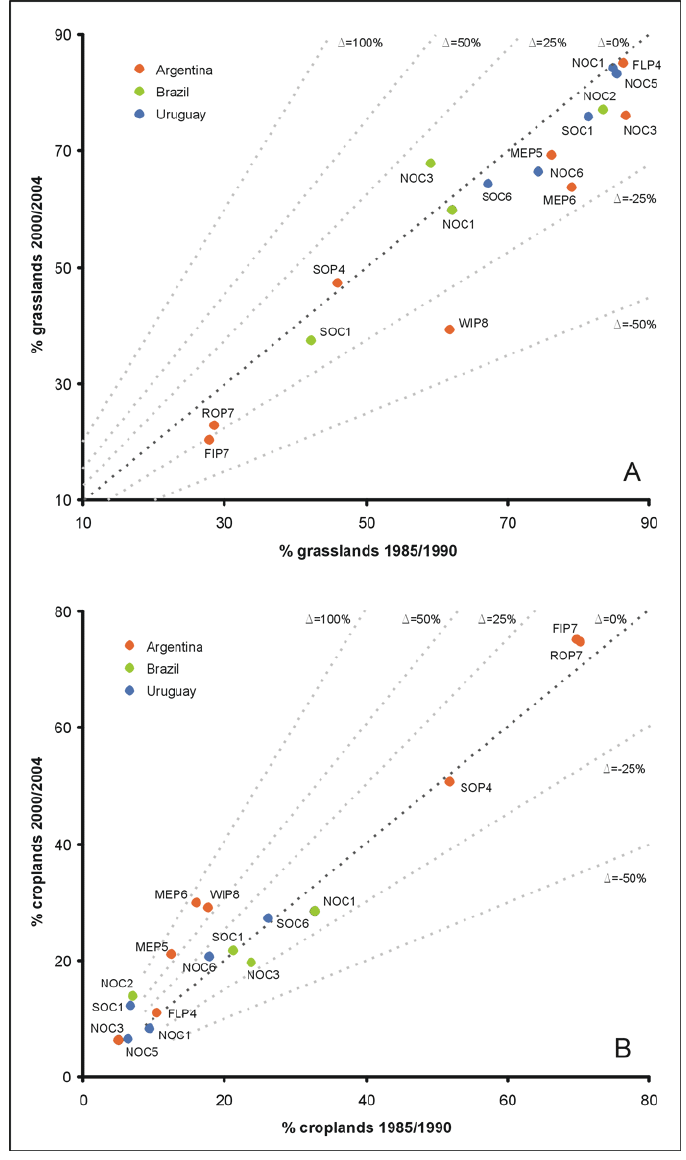
Fig. 3. Percentage of land cover (PLAND) for (A) grassland and (B) cropland for 1985–1989 and 2002– 2004, discriminated by pilot area, subunit, and country. Dotted lines indicate the thresholds of relative - Y change in grassland area, calculated as D = 100( Y )/ Y , where Y is the area of the land- relative final initial initial use and land cover type. The abbreviations indicate the subunit (letters) and pilot area (Landsat scene; numerals): NOC = Northern Campos, SOC = Southern Campos, SOP = Southern Pampa, FLP = Flooding Pampa, WIP = West Inland Pampa, FIP = Flat Inland Pampa, MEP = Mesopotamic Pampa, ROP = Rolling Pampa, 1 = 222/083, 2 = 223/081, 3 = 224/080, 4 = 224/086, 5 = 225/082, 6 = 225/083, 7 = 227/083, and 8 = 229/084. The number of grid cells included in each combination is given in Table